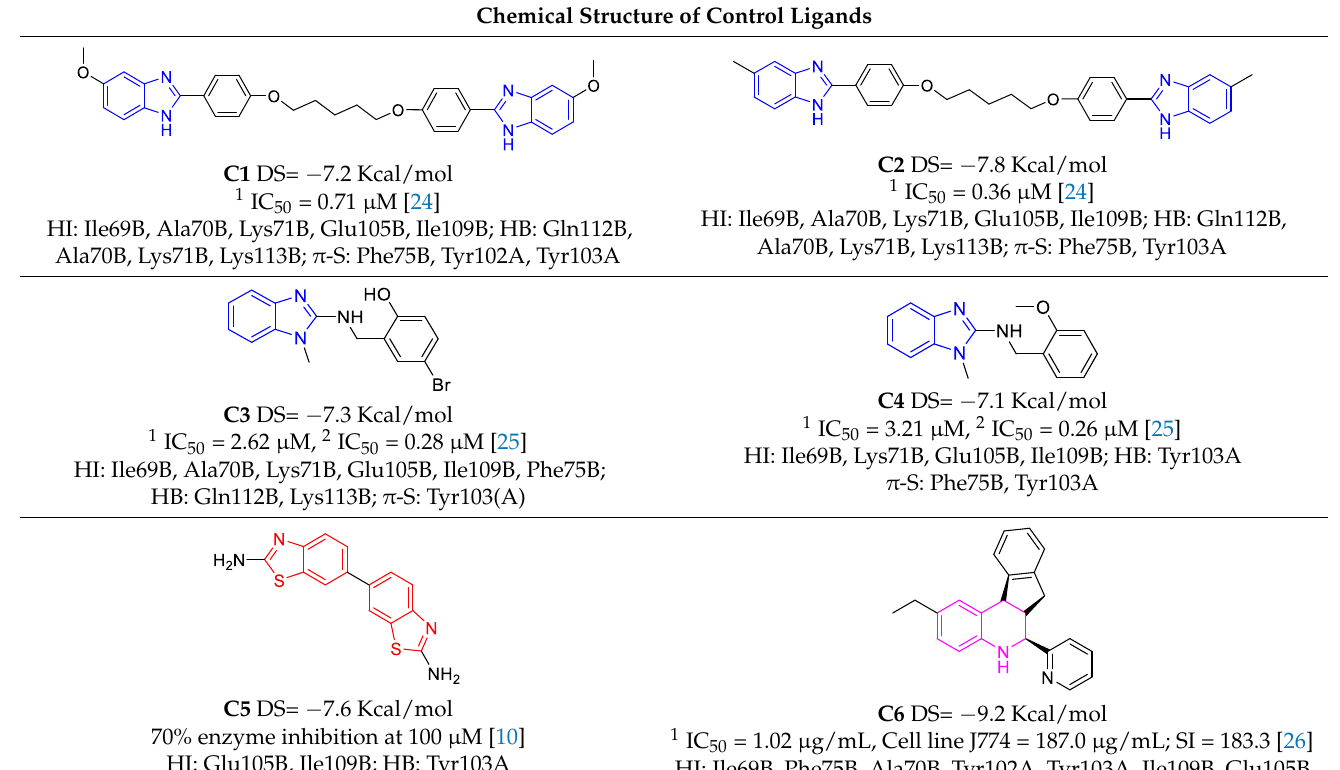
Table 1. Docking scores and molecular interactions of compounds used as control ligands at the Lm TIM interface.